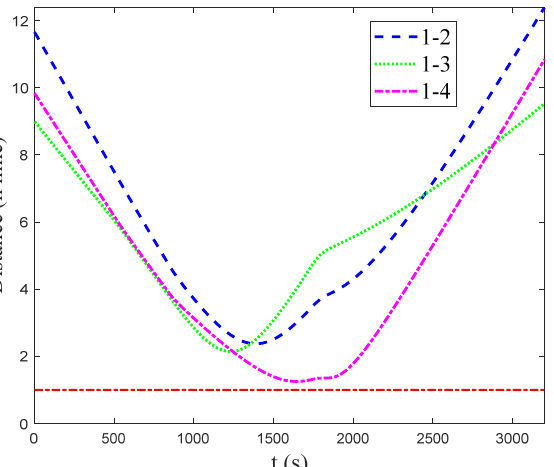
Figure 28. The distance between ship–1 and other ships in scenario 3 under environment disturb ‐ ance.